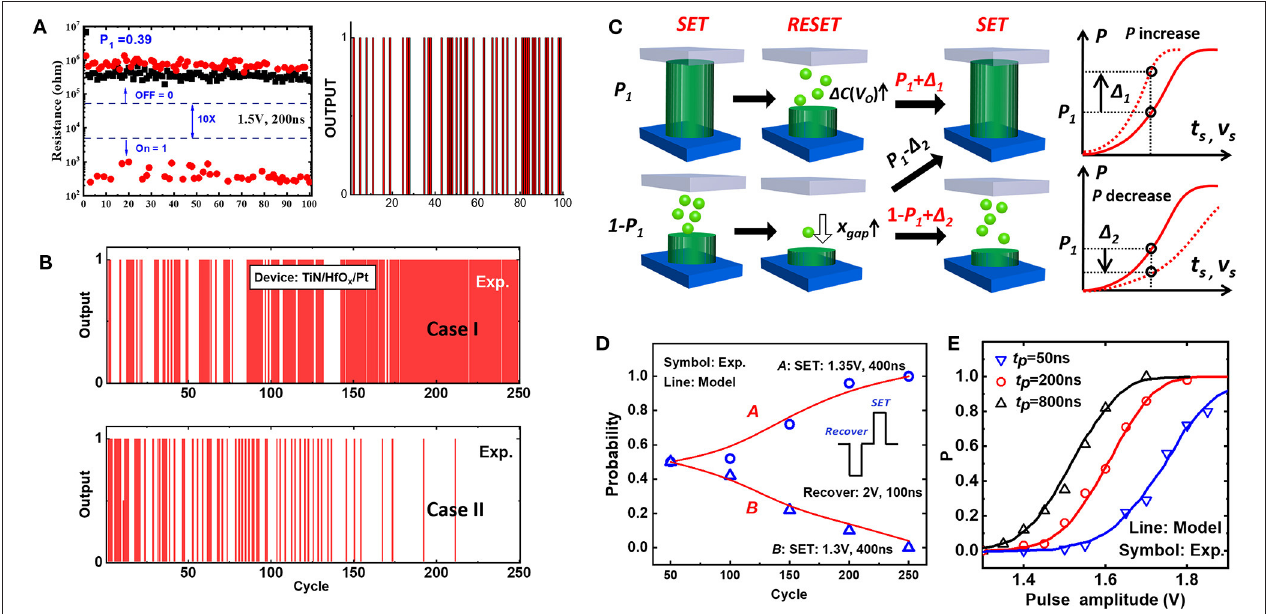
FIGURE 10 | (A) The measured resistance state after 100 consecutive SET and RESET pulses and the corresponding SBS. (B) The measured SBS with probability shift behavior between continuous cycles with the same initial probability. (C) The model of probability shift behavior. (D) The measured and calculated SET probability shift behavior. (E) The measured and calculated SET probability curve with different pulse intensity under optimized operation scheme. Reprinted from Zhao et al. (2019)